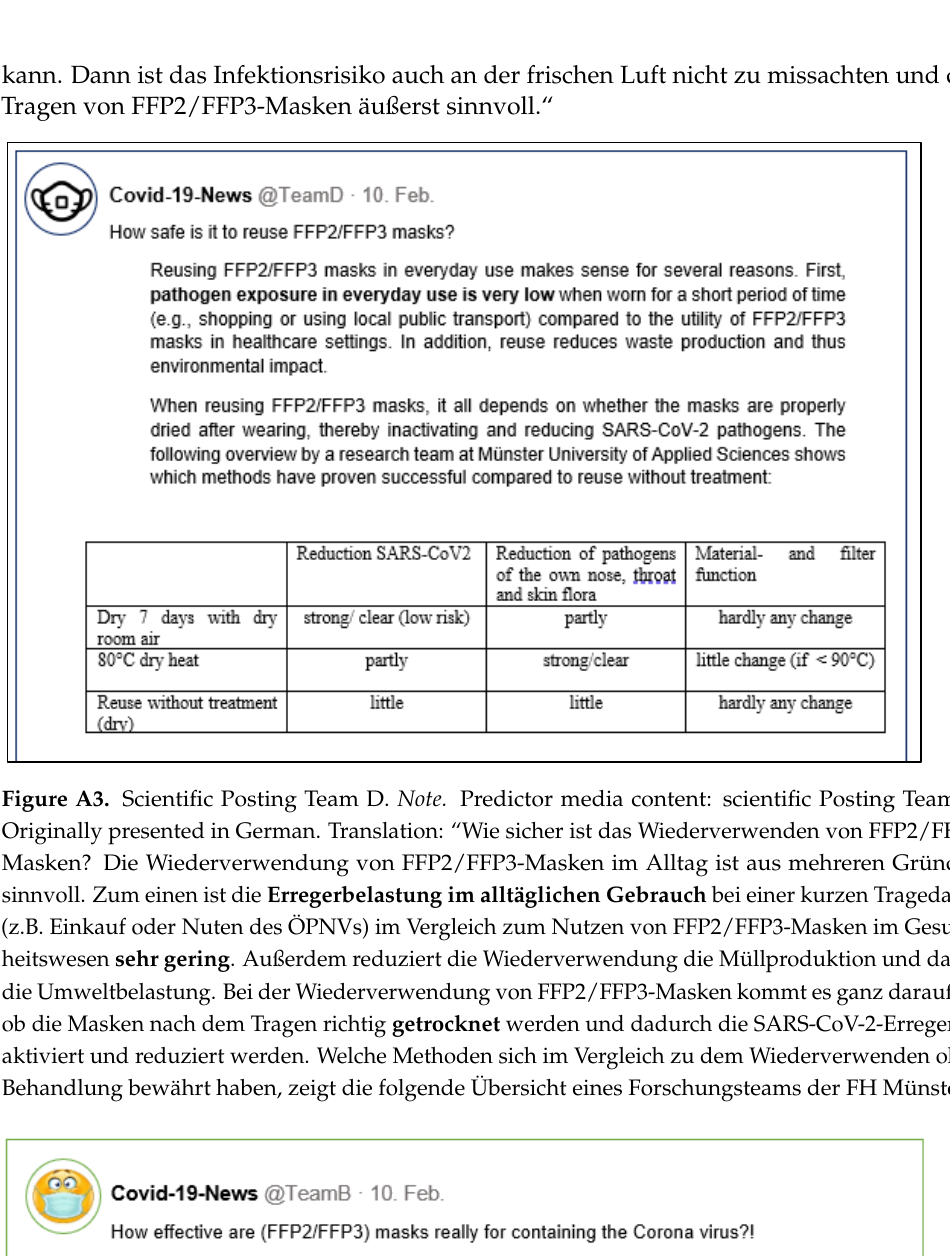
15 of 20 Figure A2. Scientific Posting Team E. Note. Predictor media content: scientific Posting Team E. Orig- inally presented in German. Translation: “Wann.ist es sinnvoll, FFP2/FFP3-Masken auch an der